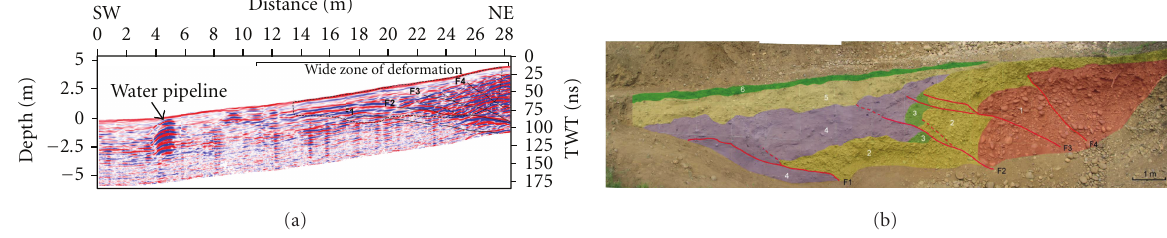
Figure 3: (a) Processed 2D GPR profile collected using 200 MHz antenna across the HF2 scarp at Sandhwal Village (refer to Figures 2(a) and 2(b) for location). The profile was about 29m long showing the processed profile after topographic correction. Reflections at 4-5m indicate water pipeline, whereas the reflections from 14–28 m show the fault traces. Box with dotted line shows approximate area of a trench. (b) Interpretation with fault traces and stratigraphic units on north wall of trench excavated across HF2 fault scarp. F1, F2, F3, and F4 are the thrust faults dipping in NE direction. Latest event has been observed along F1, F2, and F3 displacing the units 1, 2, 3, and 4.